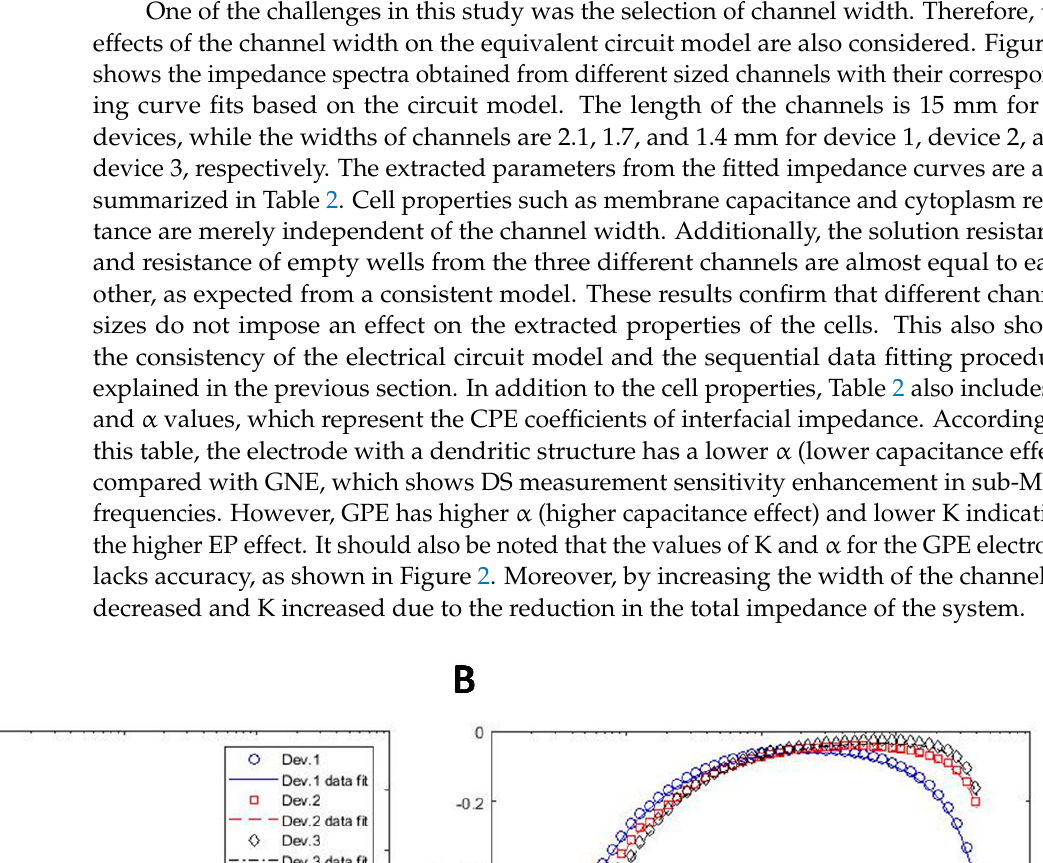
Figure 4 . Time independence of the cell membrane capacitance ( C mem ) and cytoplasm resistance (R cyt ) of PC-3 cells suspended in high conductive growth media (RPMI-1640) for 1000 s. The employed frequency range to extract cell properties in this study was 10 kHz − 40 MHz. The fitted data in